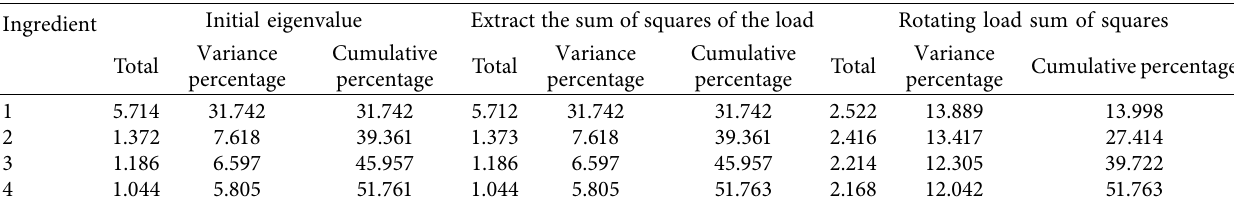
Table 5: List of explanations of the total